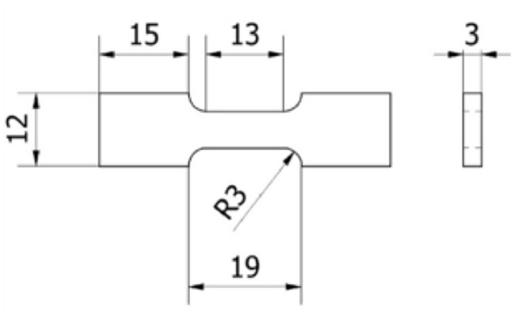
Figure 1. Schematic diagram of tensile tests specimens 23 . Table 1. The chemical composition obtained by X-ray fluorescence spectrometry. Element Ti Nb Fe O N Composition (wt.%)